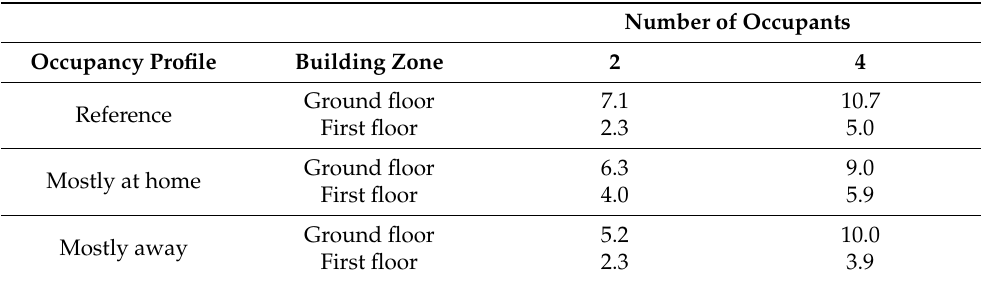
Table 6. The annual average specific, per m 2 usable area, electricity demand from appliances for different occupancy scenarios. Values are in W/m 2